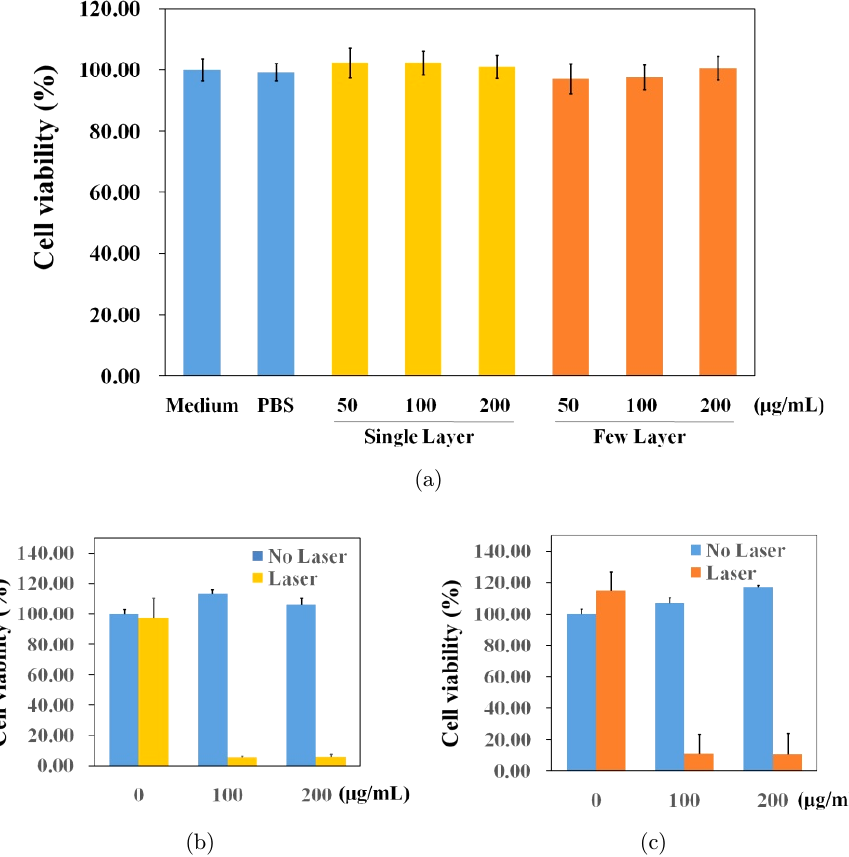
Fig. 3. (a) Cell viability of 4T1 cells after incubation with di®erent concentrations of MoS 2 SL or MoS 2 FL nanosheets after 24 h incubation. (b) – (c) Cell viability of 4T1 cells treated with MoS 2 SL (b) or MoS 2 FL (c) nanosheets with or without laser irradiation (808 nm, 1 W/cm 2 , 5 mins). Data are shown as mean (cid:4)